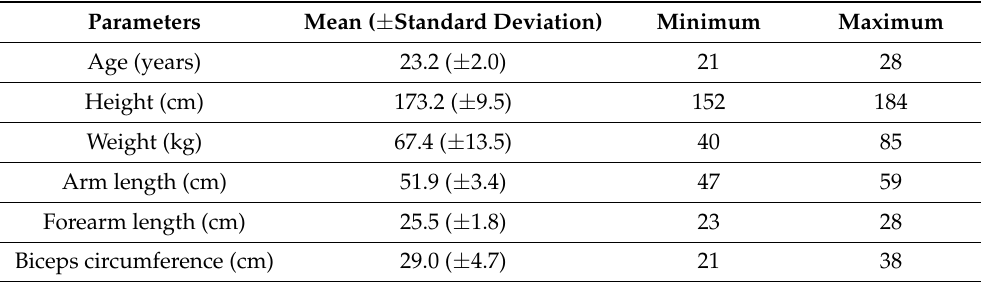
Table 3. The participants’ demographic and anthropometric characteristics.